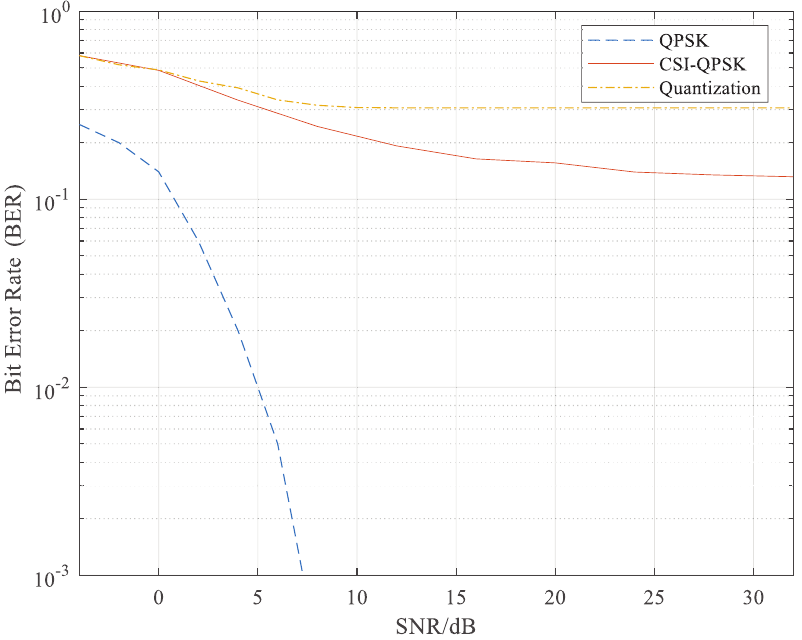
Figure 10. BER curves of QPSK, CSI-QPSK, and Quantization methods